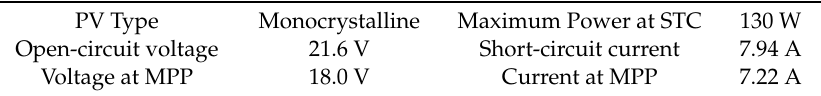
Table 1. Photovoltaic (PV) panel characteristics.